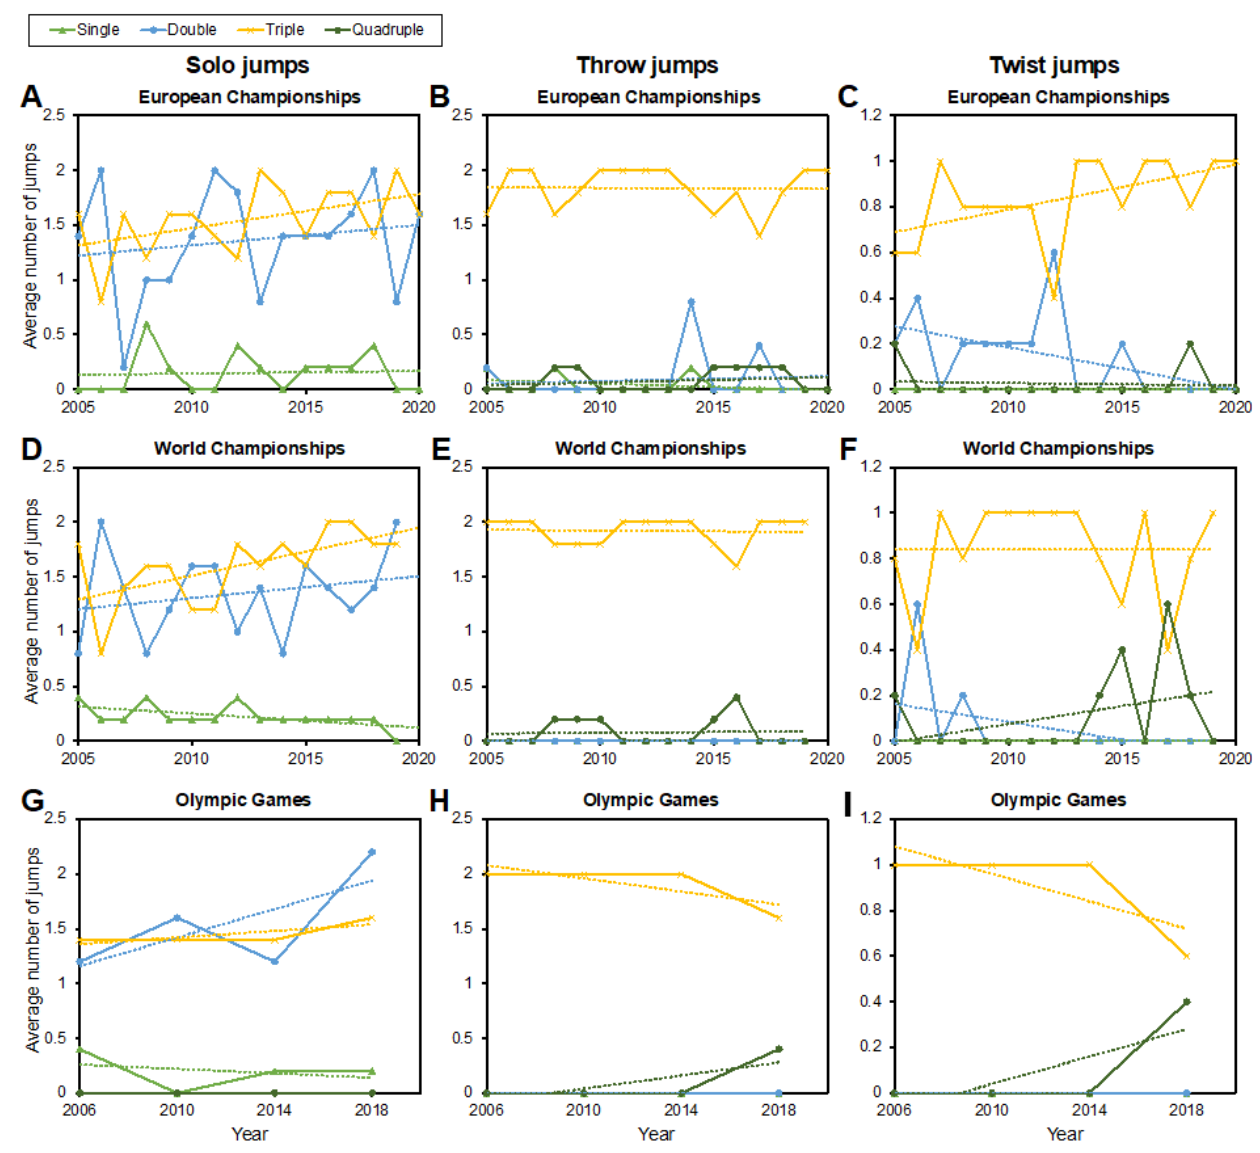
Figure 2. Jump types and trends of the average number of jumps of the best five pairs in pair skating. Results are separated by solo jumps ( A , D , G ), throw jumps ( B , E , H ) and twist jumps ( C , F , I ), and shown for the European ( A – C ) and World ( D – F ) Championships, as well as for the Olympic Games ( G – I ). See Table 1 for regression statistics.